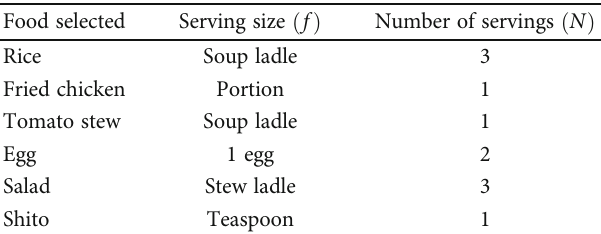
Table 1: Sample meal with various food components and